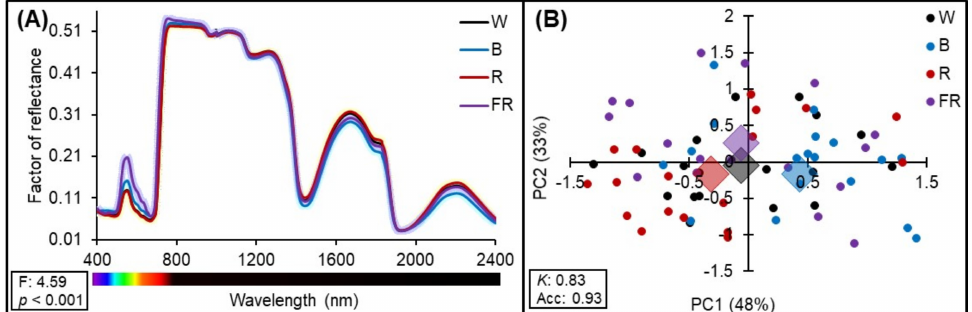
Figure 1. ( A ) Average factor of reflectance profile of tobacco leaves grown at different light quali- ties. White (W), blue (B), red (R) and red added to far-red (FR); F and P values from permutation analysis of variance (PERMANOVA) for the effects of light qualities on the full range (400–2400 nm) of hyperspectral reflectance to tobacco leaves are reported in the bottom-left corner of the panel. ( B ) Principal component analysis score for the first (PC1) and second (PC2) principal components of the hyperspectral reflectance data (400–2400 nm) collected from tobacco plants. Average accuracy (Acc) and Kappa (K) values from partial least squares regression (PLSR) are reported in the bottom-left corner of the